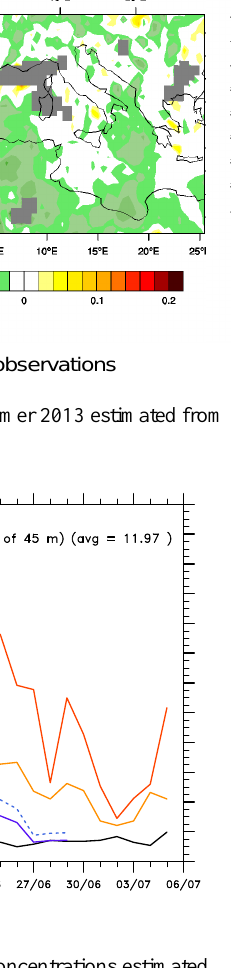
Figure 13. Time series of daily PM mass concentrations estimated at the Lampedusa (PM 40 and PM 10 ) and Ersa (PM 1 and PM 10 ) super-stations. Problems in PM 10 data acquisition that occurred at Ersa explain the gaps. PM 10 Ersa corrected curves correspond to PM 10 estimated at an altitude of 45m to be comparable with Lampedusa results, following the logarithmic law provided by Pi- azzola et al. (2015) (see text in Sect. 5.1.1 for